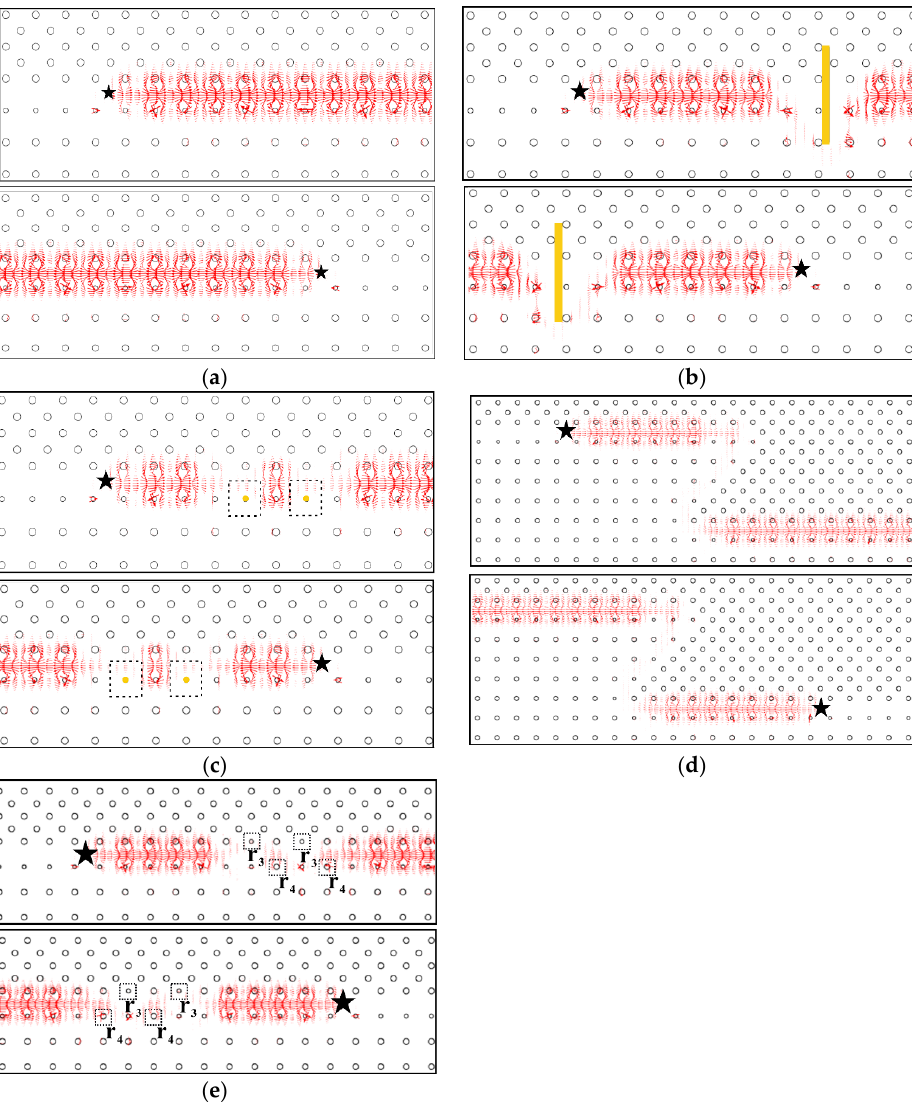
Figure 8. The Poynting vectors distributions at 4.2926 GHz in the unidirectional slow light PCW for parameters r 1 = 0.078 a , r 2 = 0.115 a ( a ) in the absence of the obstacles; ( b ) with an inserted metal reflector (indicated by the yellow rectangle); ( c ) with two YIG rods replaced by Copper rods (circled in the black rectangles) of the same size; ( d ) with a Z-shaped interface; ( e ) with rod defects (circled in the black rectangles and the corresponding rod radii are r 3 = 0.08 a and r 4 = 0.11 a respectively). The top and the bottom plots in ( a – e ) correspond to the results of the externally applied magnetic field along + z and − z direction,